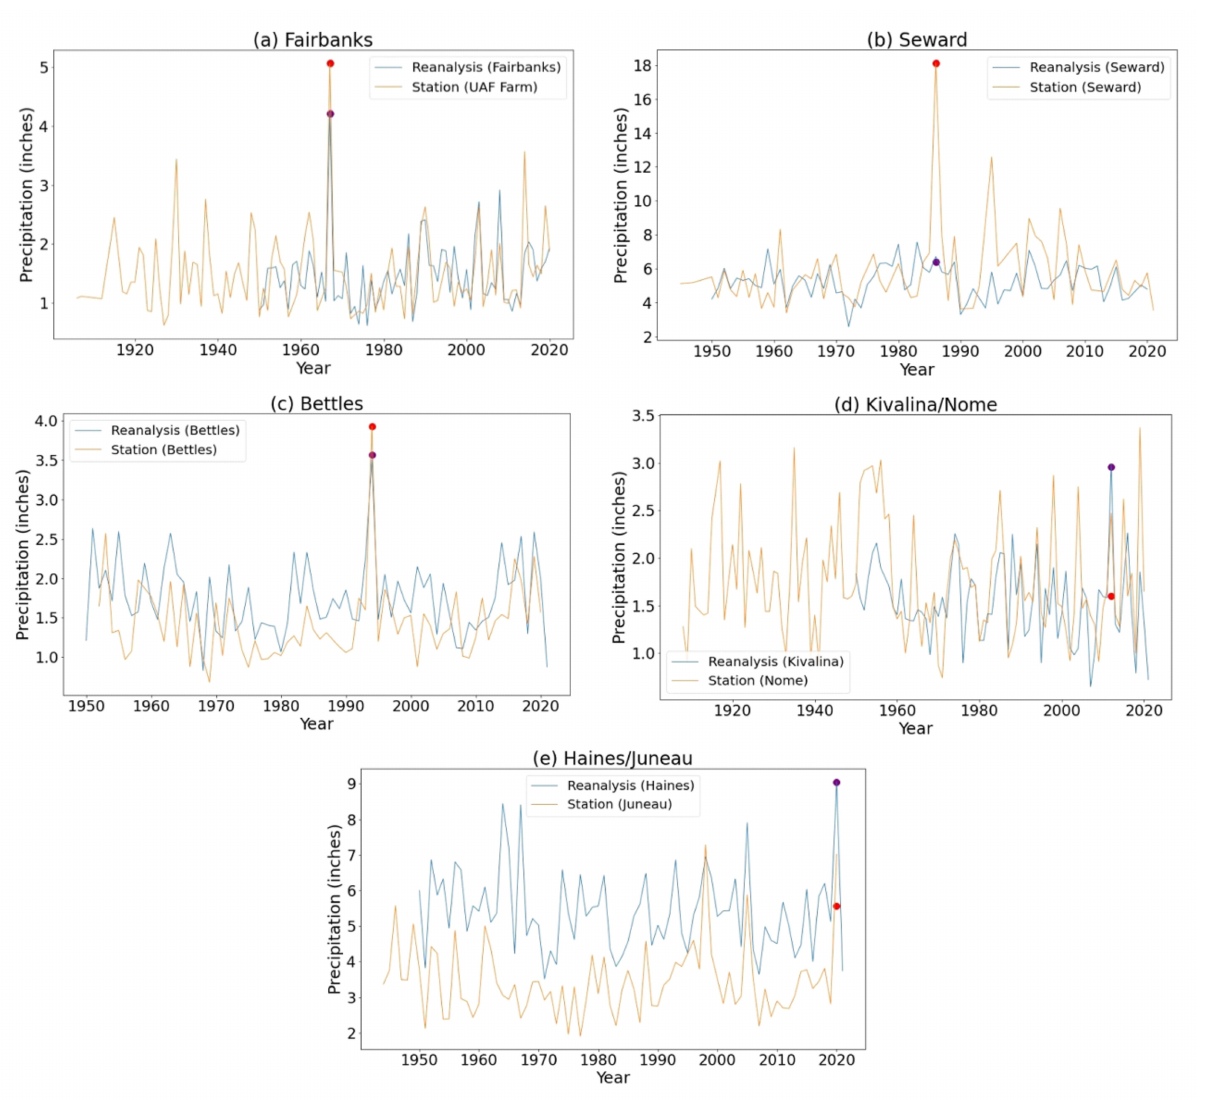
Figure 6. Time series of 3 day maximum precipitation for each year for the sites of the five flood events: ( a ) Fairbanks, ( b ) Seward, ( c ) Bettles, ( d ) Kivalina/Nome and ( e ) Haines/Juneau. Values from ERA5 reanalysis are shown in blue, while values from official observing stations are shown in orange. The red dot shows the station storm maximum, and the purple dot shows the ERA5 storm maximum. In ( d , e ), the orange lines and red dots are for the Nome and Juneau stations, where the flood events did not even produce the highest 3 day totals of the respective years. Note that some station records extend farther back in time than ERA5 (cid:48) s start date